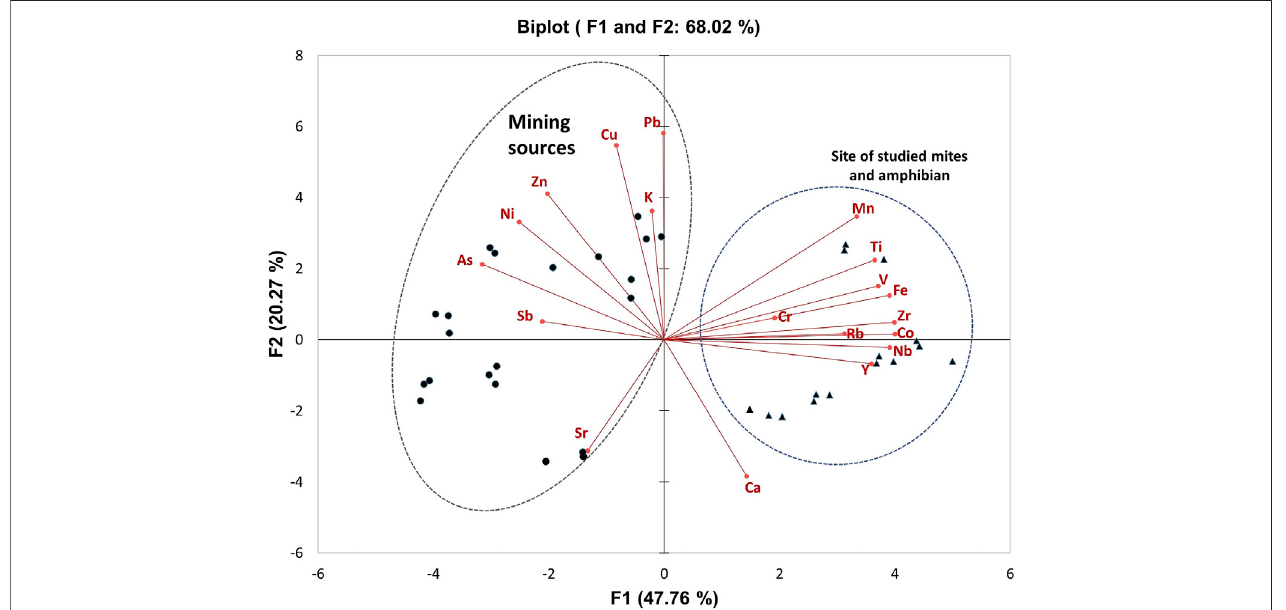
FIGURE 3 | Principal component analysis (PCA) loadings of chemical composition of studied sediments.